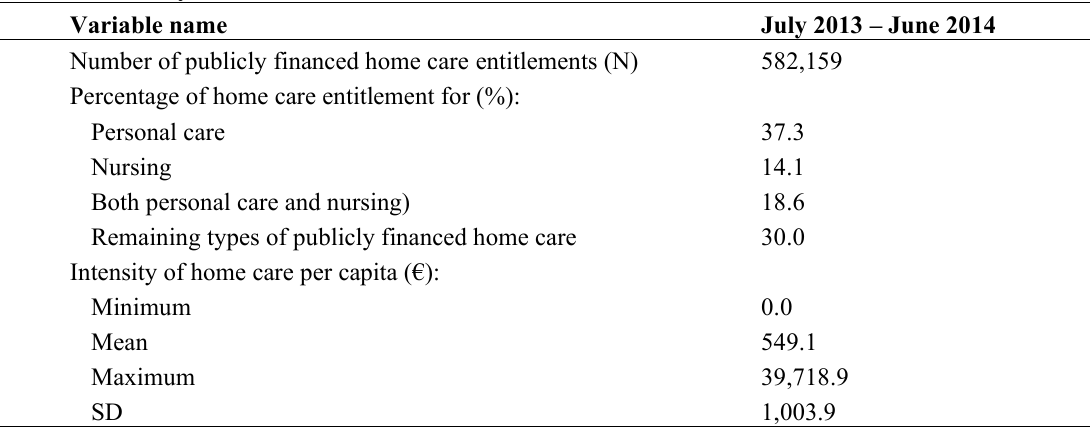
Number and percentage of publicly financed home care entitlements